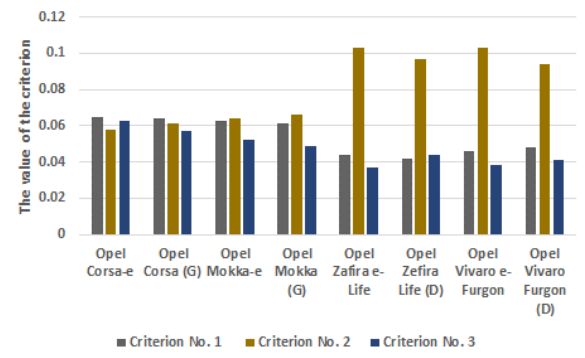
Fig. 2. Summary of criteria for selecting vehicles for testing because of the brand of vehicle. G – gasoline, D –